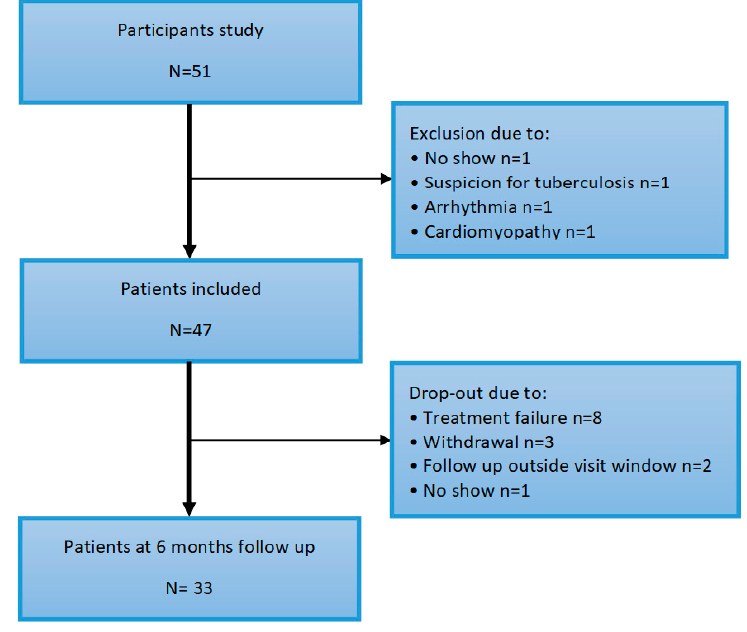
Figure 1. Flowchart of inclusion.